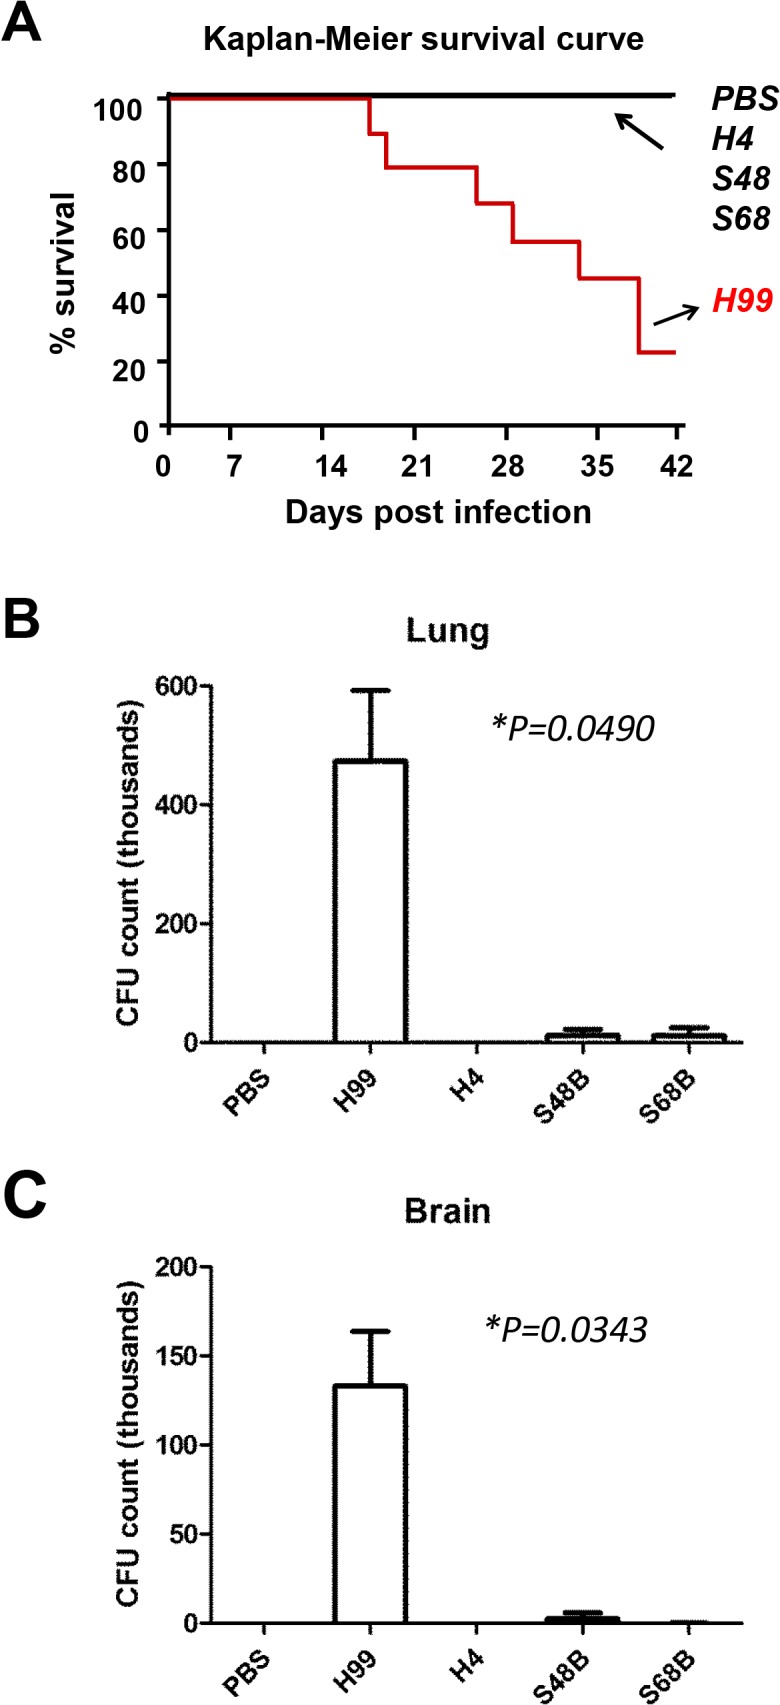

In vivo virulence study among different C. neoformans strains.(A) Kaplan-Meier survival curve. C57BL/6 mice at age 8–12 weeks old were administrated intranasally with 2 × 105 yeast cell suspension. Mice were infected with C. neoformans clinical strain H99 or environmental strains H4, S48B and S68B, and observed for a period of 42 days. (n = 6–9). (B and C) CFU assay. Lung (B) or brain (C) homogenates from C. neoformans-infected mice (n = 4) were serially diluted and plated onto agar plates in duplicates. Numbers of colonies (CFU/ml) were counted after 48 hours. CFU formations on the plates were measured and shown as mean ± SD. Group statistical significance measured was by two-way ANOVA analysis (*P<0.05).